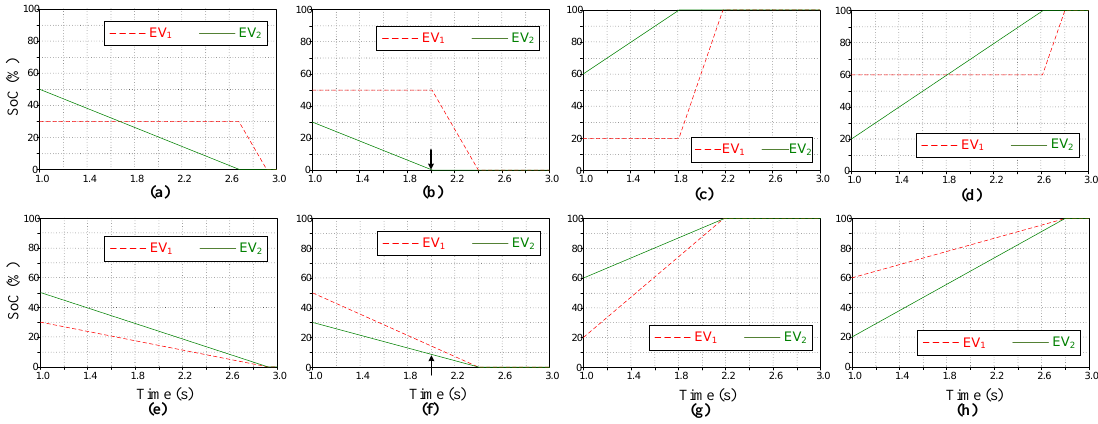
Figure 12. A comparison of power allocation schemes. ( a – d ) Reference method discharging and charging. ( e – h ) Proposed method discharging and